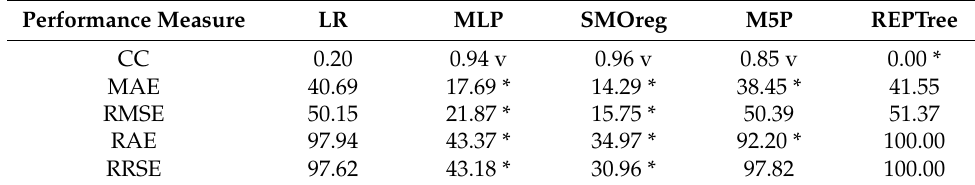
Table 5. Model comparison without using eye-tracking data. The asterisk (*) indicates statistically significantly worse and (v) indicates statistically significantly better.